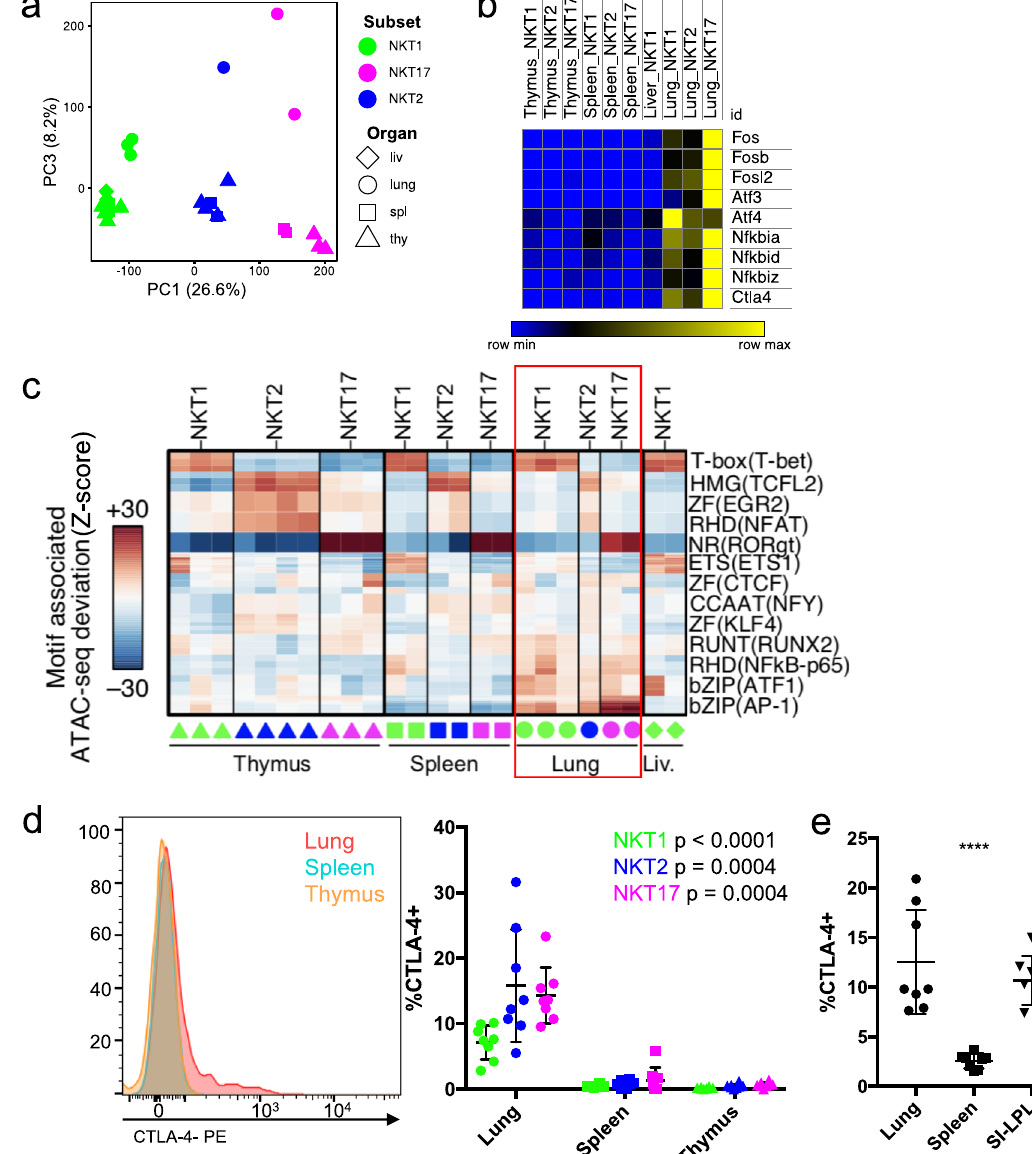
Fig. 3 Lung-speci fi c transcriptome and epigenome. a PC1 by PC3 display of ATAC-seq data showing the distribution of iNKT cell subsets from different tissues. Liver = liv. b Heat map of relative RNA expression of selected AP-1 and ATF family genes in iNKT subsets from the indicated sites. c chromVAR computed deviation in ATAC-seq signal (Z-score) at regions containing indicated transcription factor motifs. Motifs with a p value less than 1e-25 are shown and families and representative members are labeled. Samples are indicated at the bottom, iNKT cell subsets from the lung are boxed to highlight lung-enriched motifs. d Total CTLA-4 expression in permeabilized iNKT cells from the indicated tissues. Representative cytogram of total iNKT cells (left) and percent CTLA-4 + cells within each subset from the different organs (right). Symbols depict individual mice, bars depict mean and SD. Data are combined from fi ve experiments, n = 8 mice, statistical signi fi cance ( p < 0.001 for NKT1 and p = 0.0004 for NKT2 and NKT17) assessed via Kruskal – Wallis tests. e CTLA-4 expression in permeabilized total iNKT cells from indicated tissues. Symbols depict individual mice, bars depict mean and SD, n = 8 mice from two independent experiments. Statistical signi fi cance ( p < 0.0001) assessed via one-way (Fig. 5a, right). These data suggest that most of the splenic motifs (Fig. 5c). Notably, the two populations from α GalCer iNKT cells were exposed to the antigen, including those that did immunized mice had increased accessibility for cluster 7, with not become NKT FH . motifs for T-box proteins and to a lesser extent NF- κ B (RHD We partitioned all differentially accessible regions between NKT FH and NKT eff cells and splenic iNKT cell subsets from unimmunized mice into ten groups with k -means clustering to identify regions with similar changes in ATAC-seq signal. As above, we examined the degree to which the regions in each group were differentially accessible in iNKT cell populations (Fig. 5c) and their association with DNA-binding protein